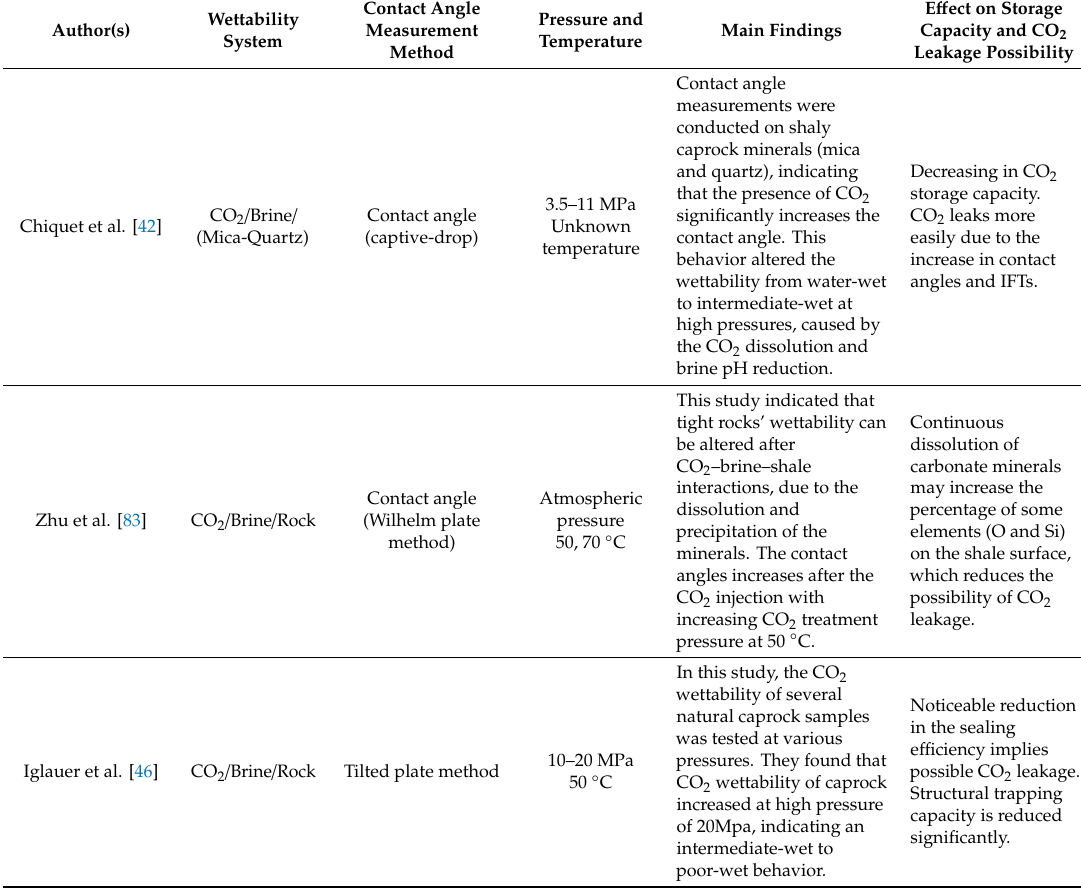
Table 3. Summary of related work on the e ff ect of CO 2 injection on wettability and contact